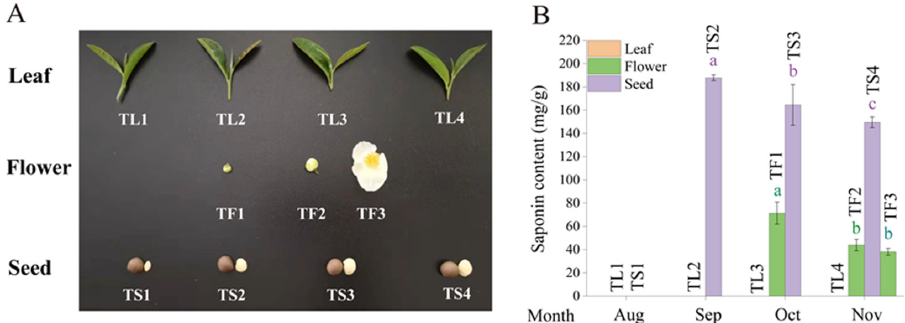
Figure 1. Changes of saponin content in different tissues of the tea plant. ( A ) The tea leaves, flowers and seeds were collected from September to November. ( B ) The saponin content in different samples. Data represent means ± SD from three biological replicates. Different letters indicate significant differences ( p < 0.05).